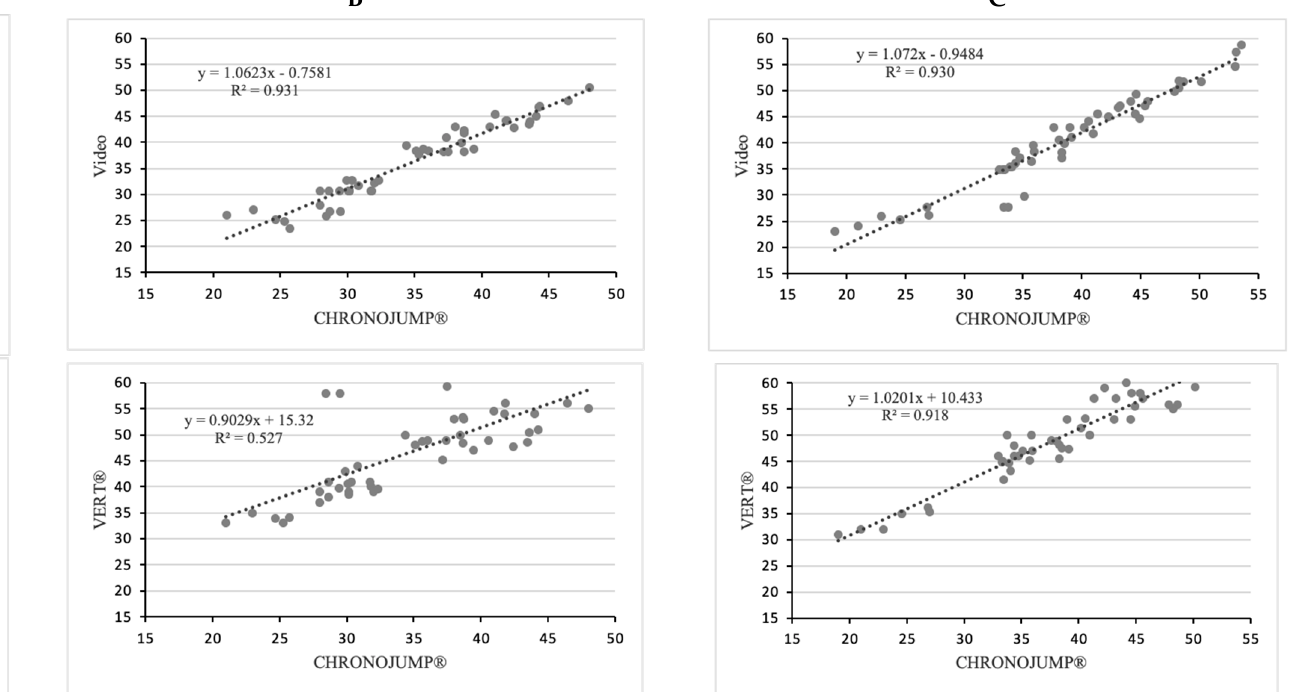
Figure 2. Relationship between CHRONOJUMP ® and other instruments (Video and VERT ® ) for ( A ) SJ: squat jump; ( B ) CMJ: countermovement jump; and ( C ) Abalakov jump. R 2 : Pearson’s multivariate coefficient of determination. The variables analyzed were the jump height measured in centimeters.